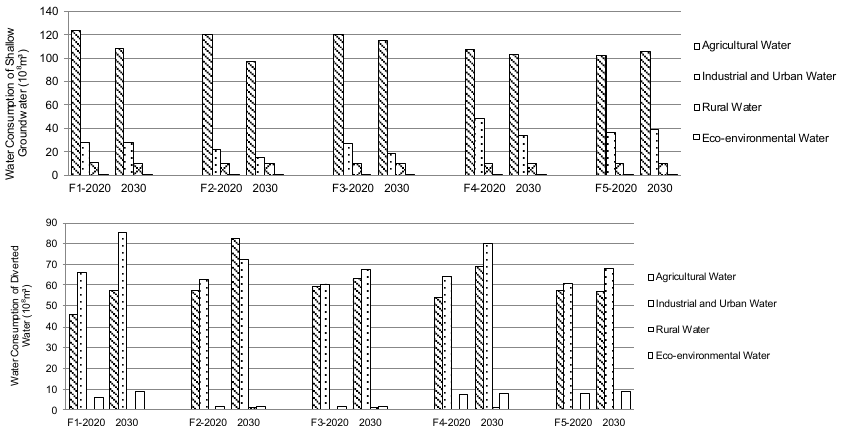
Fig. 4 The distribution from shallow groundwater and diverted water to different water-using